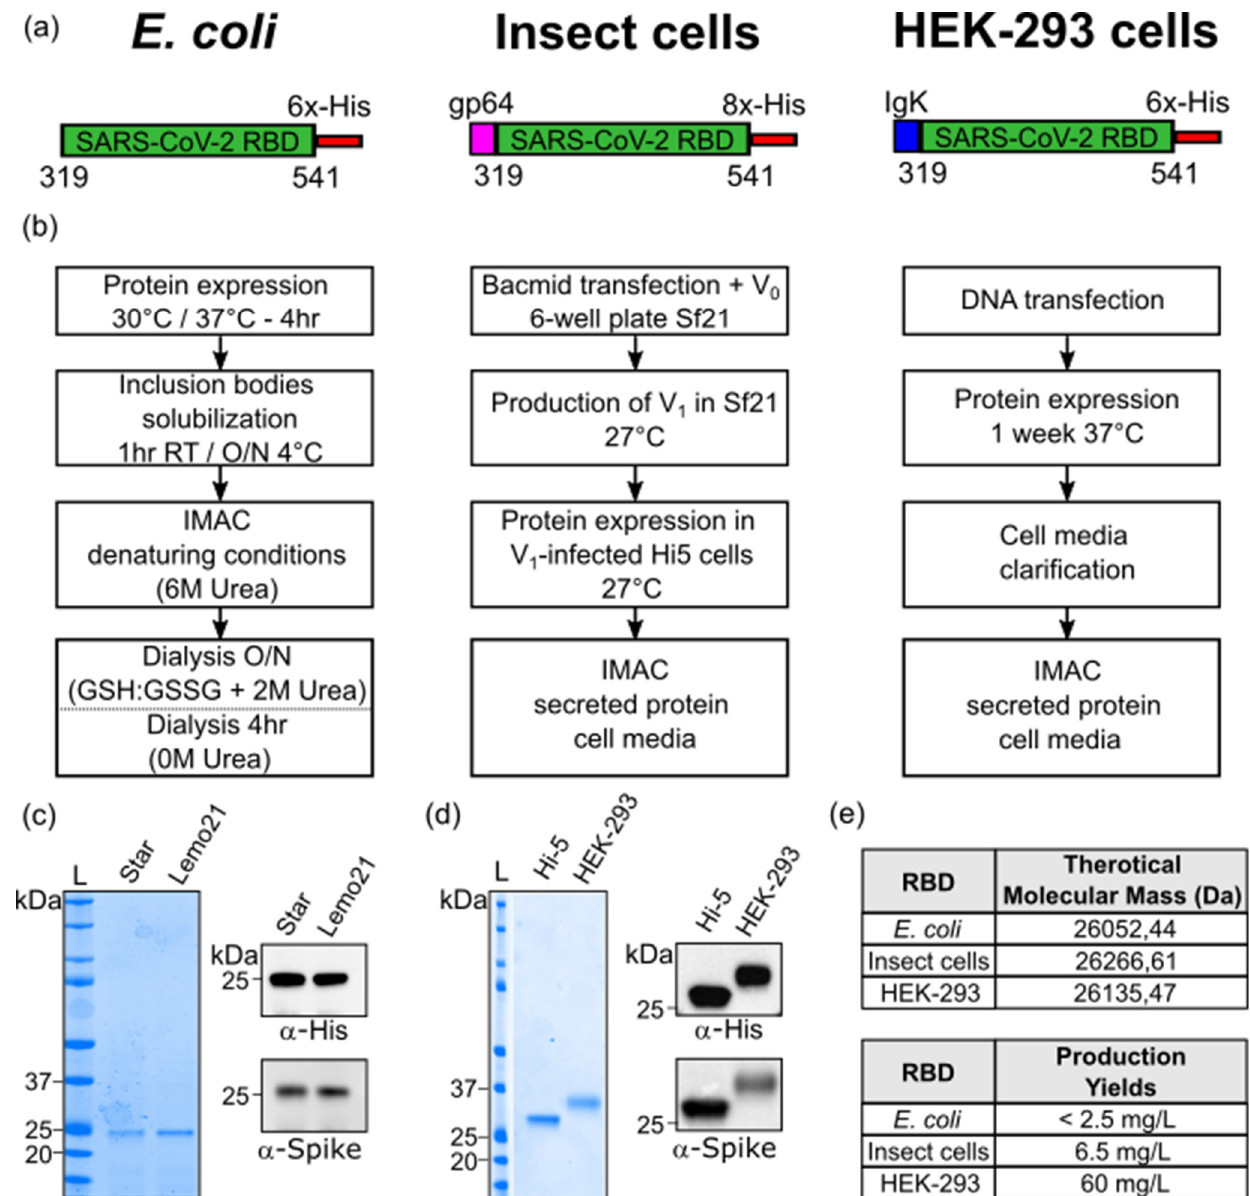
Figure 1. SARS-CoV-2 RBD production in E. coli , insect and mammalian cells. ( a ) Schematic representation of the RBD protein constructs expressed in E. coli (left), insect cells (middle) and mammalian HEK-293 cells (right). ( b ) Diagram summarizing the RBD recombinant expression from E. coli (left), insect cells (middle) and mammalian HEK-293 cells (right) and the subsequent purification. ( c ) SDS-PAGE (left panel) and Western blot analysis (right panels) of E. coli -purified RBD protein. ( d ) SDS-PAGE (left panel) and Western blot analysis (right panels) of RBD fragment produced in Hi-5 insect cells and mammalian HEK-293. L = molecular weight ladder. ( e ) Theoretical molecular masses calculated according to RBD amino acid composition (above) and RBD production yields